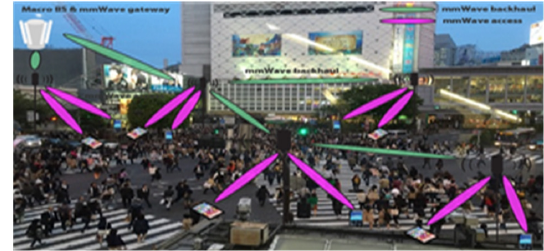
Figure 5. Dense urban scenario around Shibuya station in Tokyo